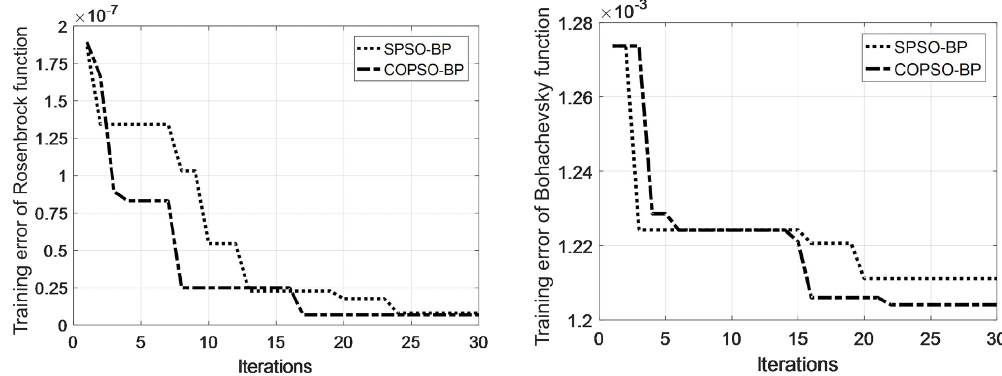
Figure 3. Training error curves of the SPSO-BP and COPSO-BP